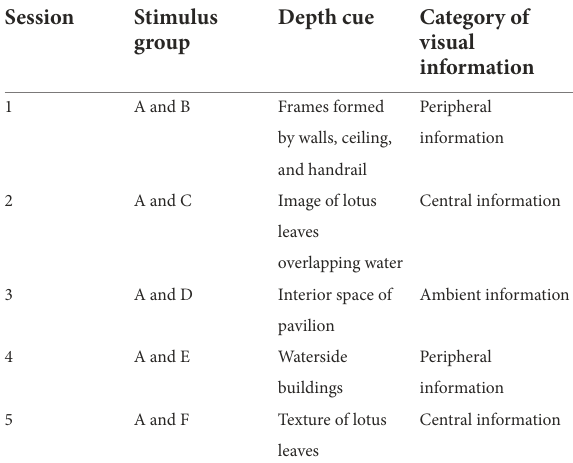
TABLE 2 The five sessions of the